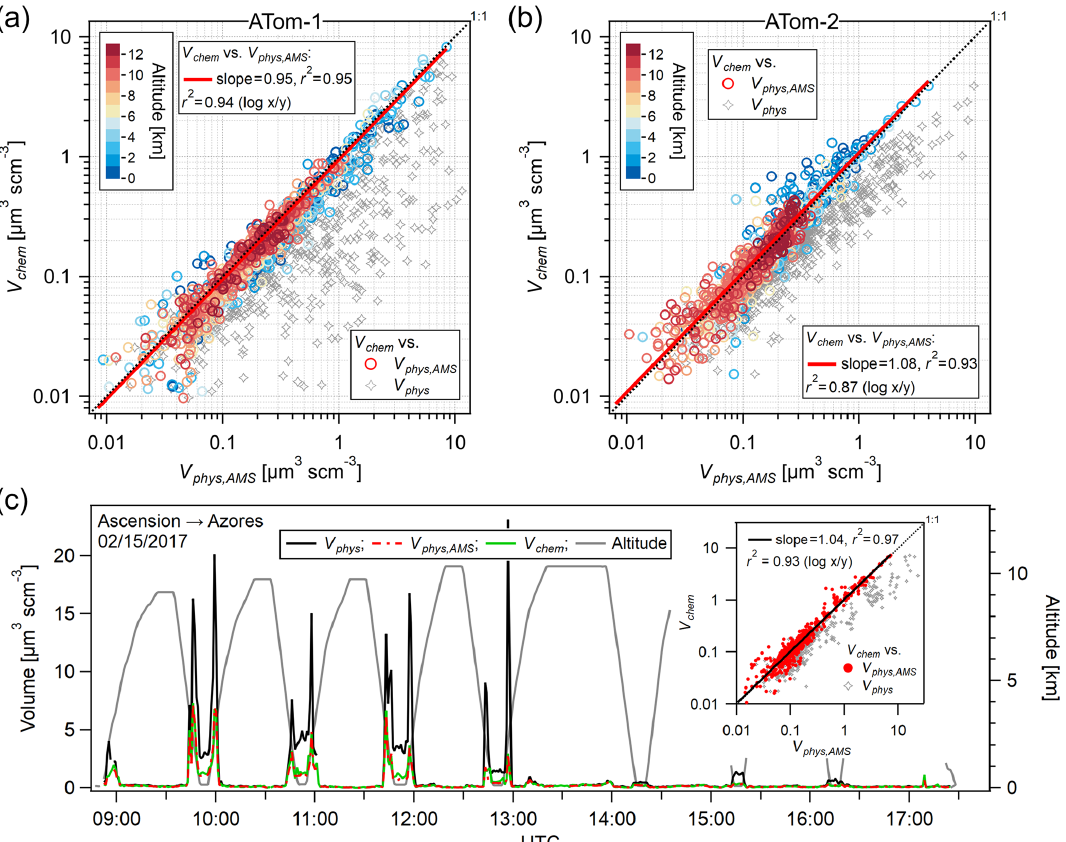
Figure 4. Comparison between V chem and V phys , AMS for (a) ATom-1 and (b) ATom-2, with data points colored by altitude and averaged to 5min resolution. V chem is also compared to V phys , as the gray markers, to show the effect of not applying the AMS inlet transmission. (c) A time series of these volumes for a research flight in ATom-2, with an inset showing the scatter plot only for this flight (at 1min timescale, as also shown for the time series). Note that V chem includes the AMS-quantified sea salt. Two correlation coefficients ( r 2 ) are listed: one at linear scale (commonly used) and the other at logarithmic scale, which emphasizes the scatter at low